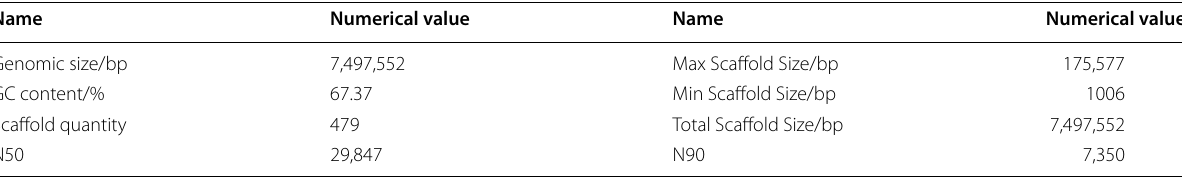
Table 2 Statistics of the genomic characteristics of Burkholderia multivorans